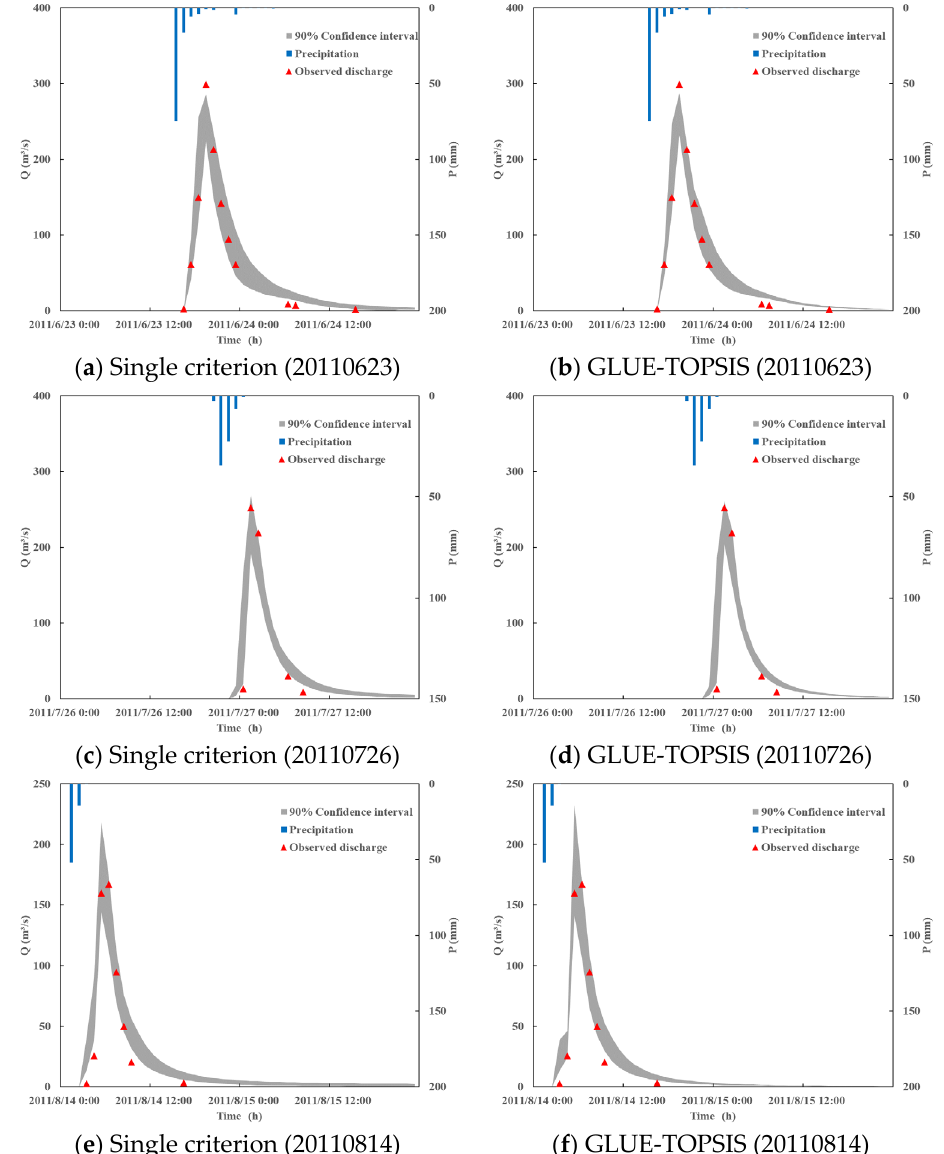
Figure 4. MCDA analysis results for rainstorm events 20110623, 20110726, and 20110814 in calibration period.